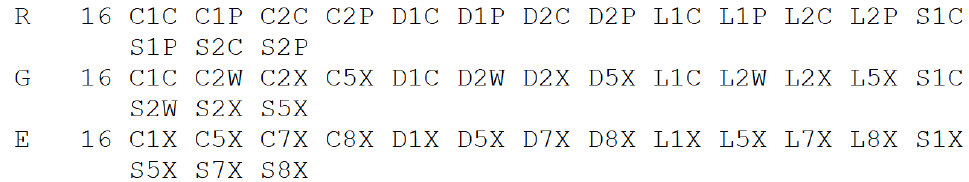
Figure 3. Header section of observation types in the observation file of HKQT. In the first column, “G, R, E” represent GPS, GLONASS, and Galileo. The second column represents the number of the observation type of the corresponding constellation. The code in the remaining columns represents the observation types of the corresponding constellation. Codes beginning with “C” represent the pseudorange observation; codes beginning with “D” represent Doppler observations; codes beginning with “L” represent the phase observation; codes beginning with “S” represent SNR observations. Table 1. System, frequency band, frequency, phase code, and SNR code of each signal for HKQT [27].